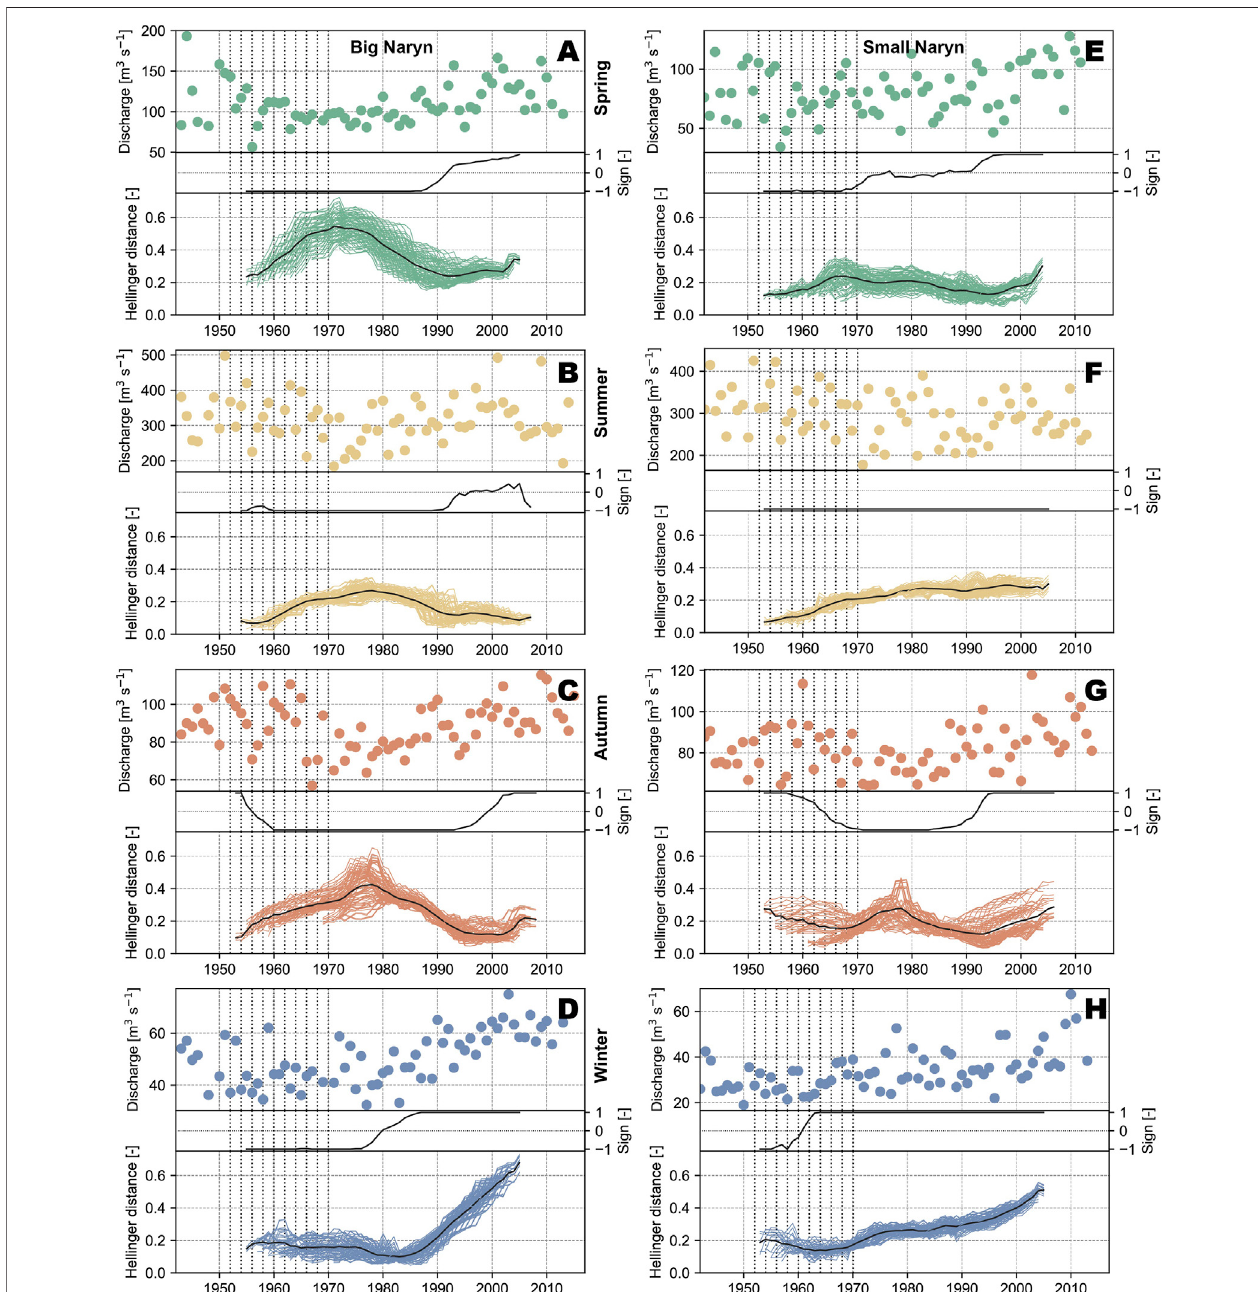
FIGURE 7| Analysis ofthe mean monthly runoff aggregated into spring (A,E) , summer (B,F) , autumn (C,G) and winter (D,H) seasons based on Hellinger distance afterPohletal.(2020),fortheBig(left)andSmallNaryn(right)catchments.Dashedverticallinesaretheyearstosplitthetimeseriesintoreferenceandtargetperiods(see Section4.6 ).Individualuppergraphsshowseasonallyaggregateddischargedata.MiddlegraphsshowthesignofchangeforeachderivedHellingertimeseriesplotted in the bottom graphs (negative – decreasing, positive – increasing). Lower graphs show Hellinger distances with different window widths and reference period end points (one line per combination) and in black the mean of all these